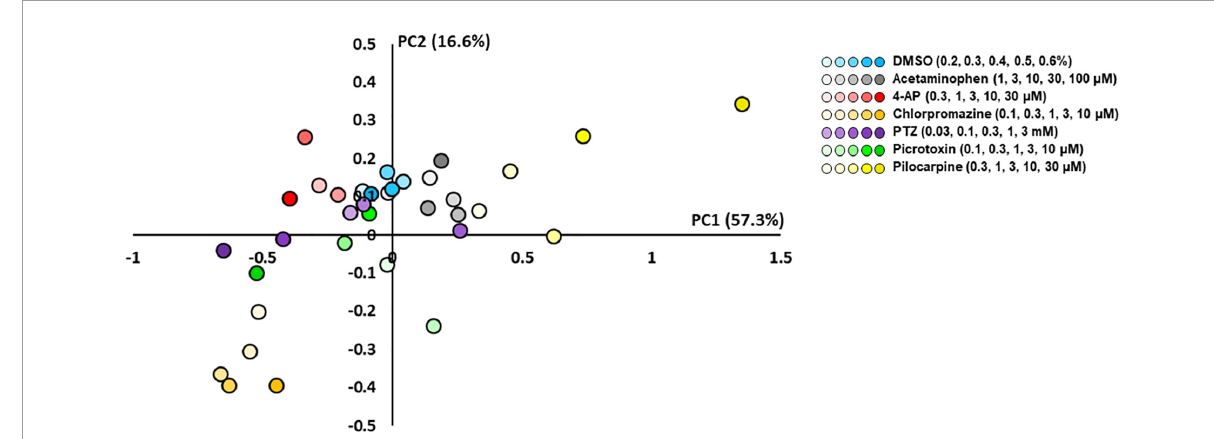
FIGURE5 Scatterplots of principal component analysis (PCA) using the effective parameter set for detecting the drug responses of primary astrocytes. There was a clear separation between the seizurogenic and neutral compounds and between all seizurogenic compounds. In neutral compounds, DMSO and acetaminophen were not separated. DMSO ( n = 6, blue), acetaminophen ( n = 6, gray), 4-AP ( n = 6, red), chlorpromazine ( n = 6, orange), PTZ ( n = 6, purple), picrotoxin ( n = 6, green), and pilocarpine ( n = 6, yellow). Higher concentrations are indicated by darker colored